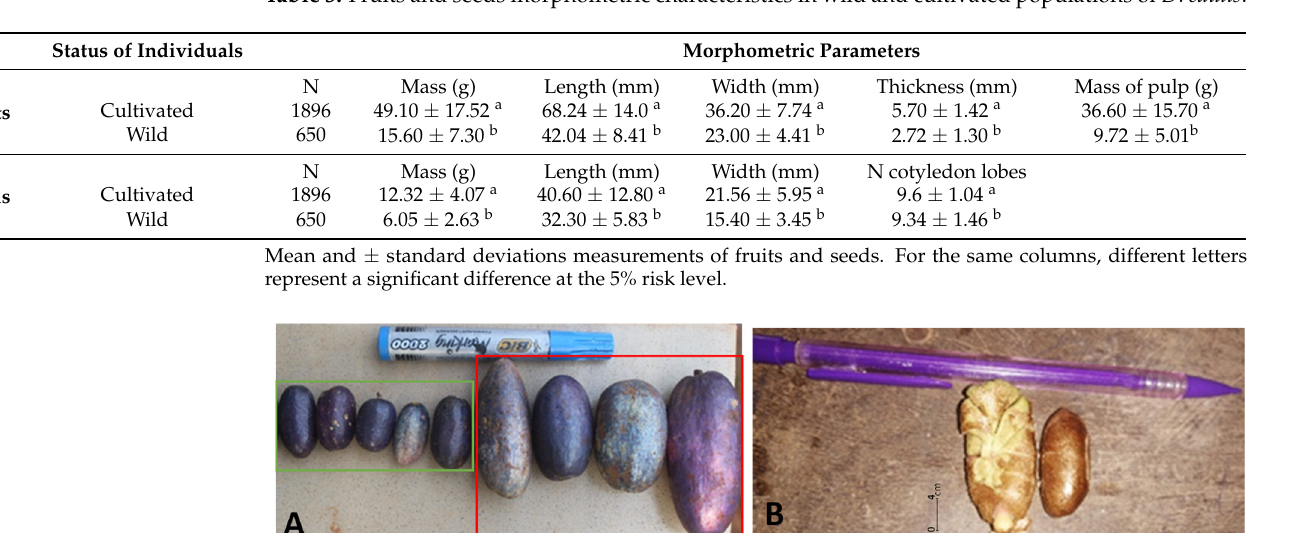
Table 3 . Fruits and seeds morphometric characteristics in wild and cultivated populations of D. edulis.